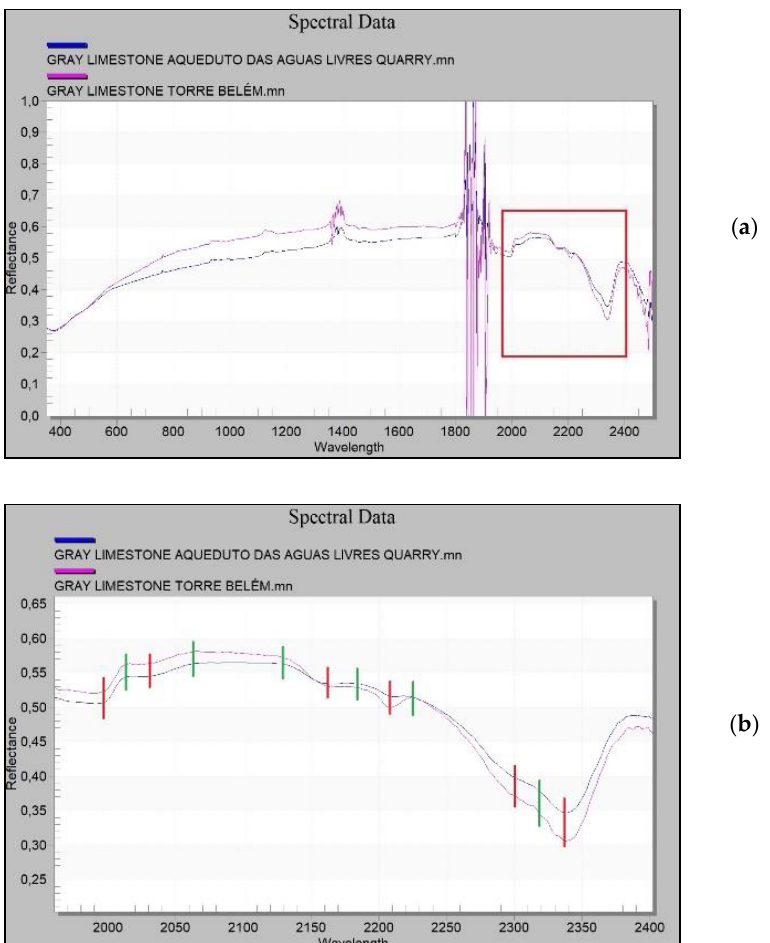
Figure 26. Comparison between the samples from the Tower of Belem and from the area of the gray limestone in the Aqueduto das Á guas Livres quarry. ( a ) Similarity between spectral signatures of the gray limestones; ( b ) Absorbance (Red) and reflectance (Green) peaks for the gray limestones studied between 2000 and 2400 nm.